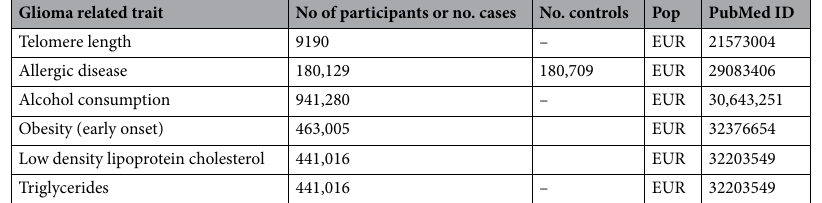
Glioma related trait No of participants or no. cases No. controls